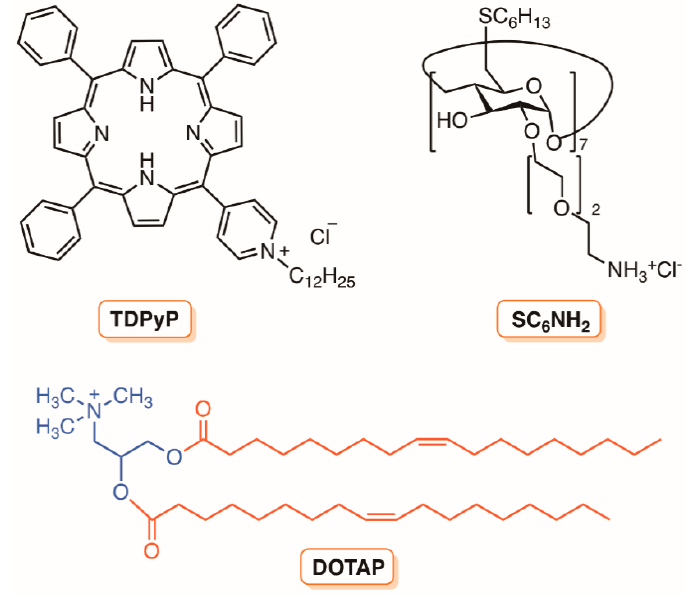
Figure 32. Structure of 5-(1-dodecanoylpyridinium-4yl]-10,15,20-triphenylporphyrin (TDPyP) and the cationic deliver systems DOTAP and SC 6 NH 2 (adapted from Reference [160]).